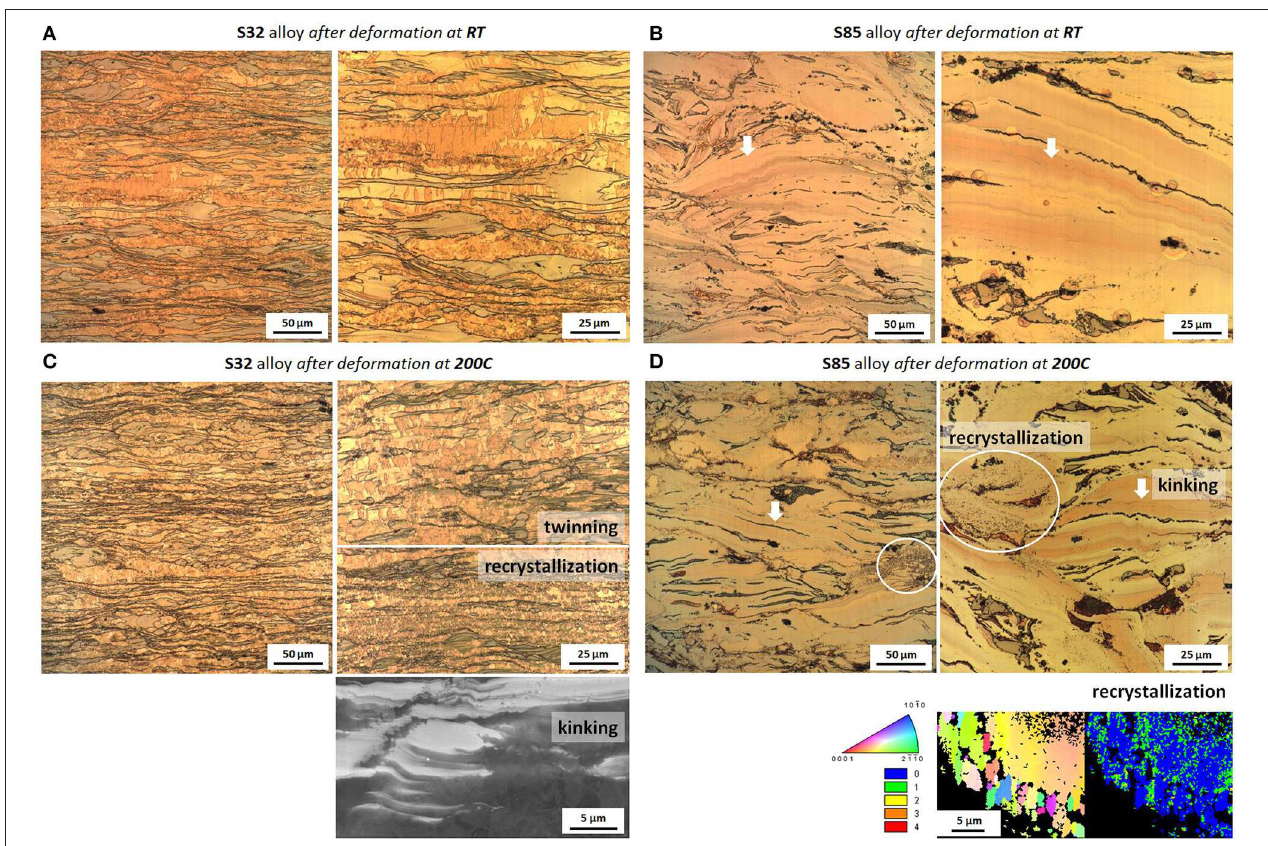
FIGURE 4 | Microstructure of the S32 (A,C) and the S85 (B,D) specimen obtained by confocal light microscope and SEM along ED after deformation at RT and 200 ◦ C, respectively. White arrows indicate kinking, white circle—recrystallization. (C) Includes detailed SEM image of kinking observed in the S32 alloy after deformation at 200 ◦ C. (D) Includes EBSD map with KAM analysis of recrystallized grains observed in the S85 alloy after deformation at 200 ◦